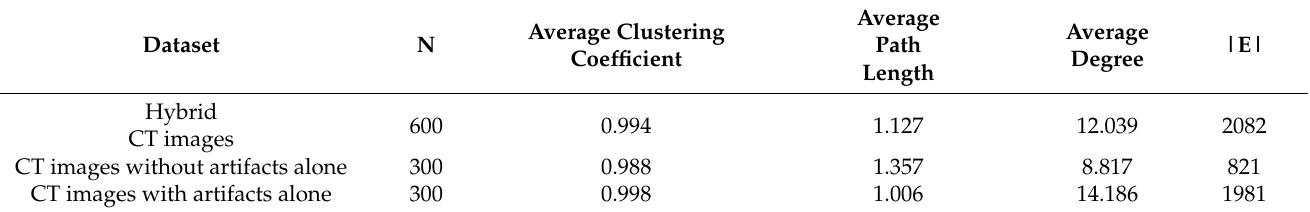
Table 3. The network topological properties of slice-level graph.